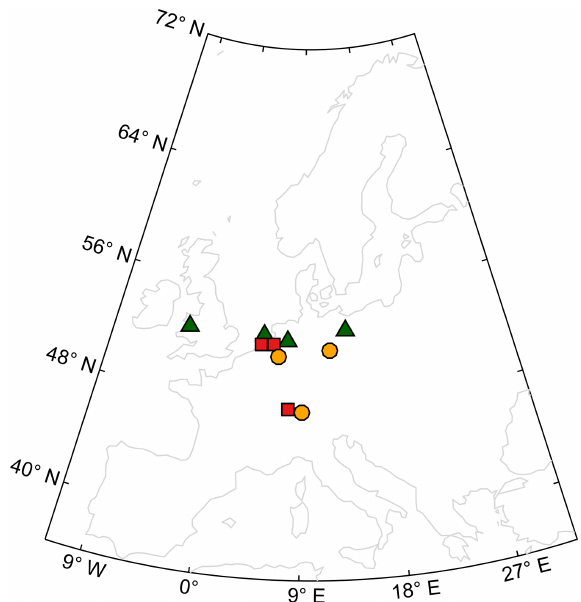
Figure A1. Location of the stations and sites listed in Table 1. Tri- angles indicate sites with forest observations. Other symbols are as in Fig.